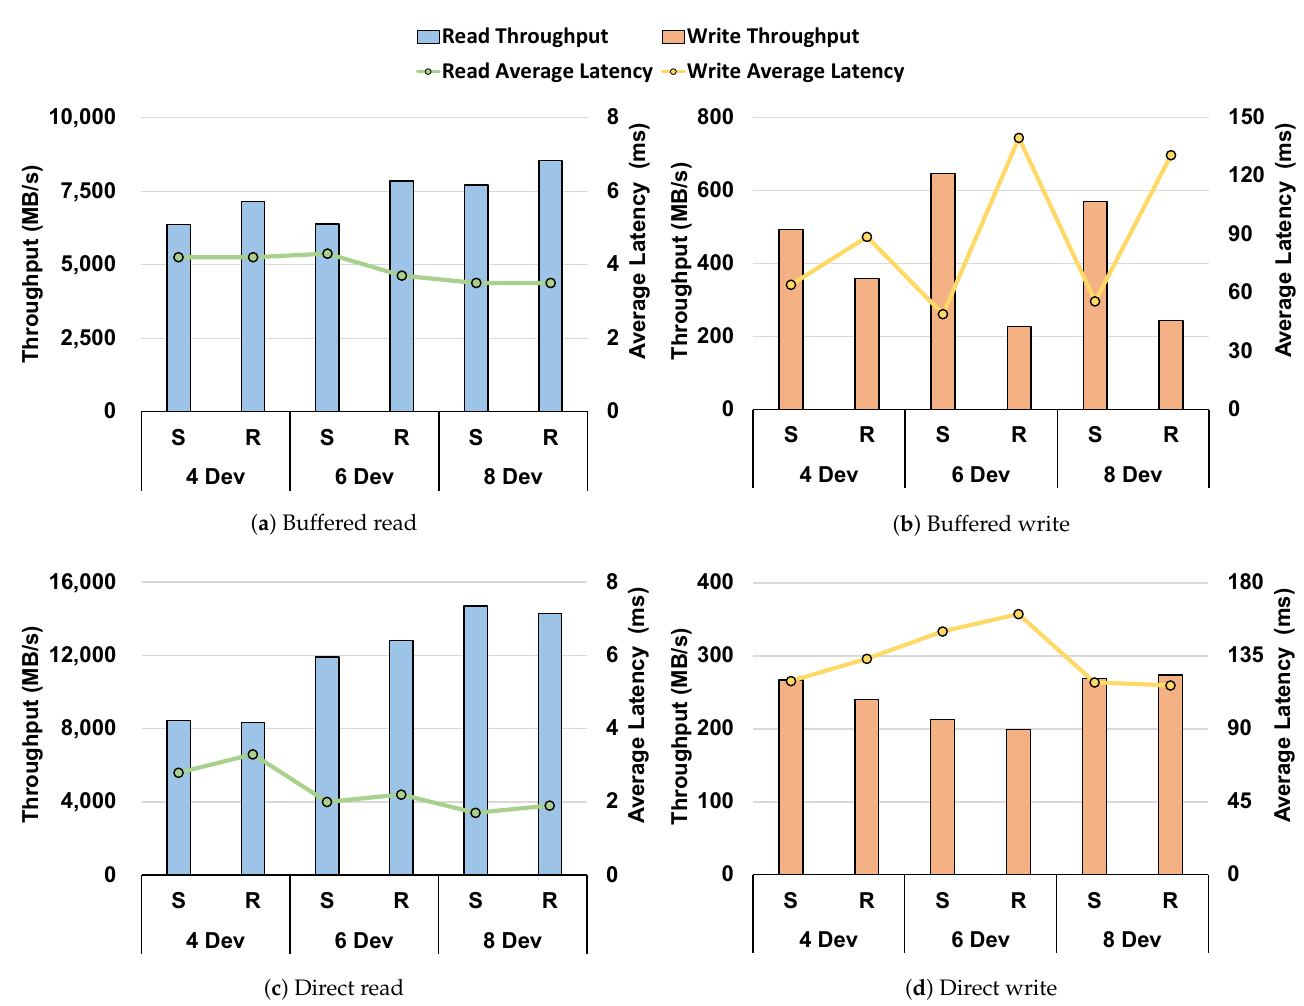
Figure 5. Experimental results under RAID 6 (S: sequential, R: random, Dev: number of